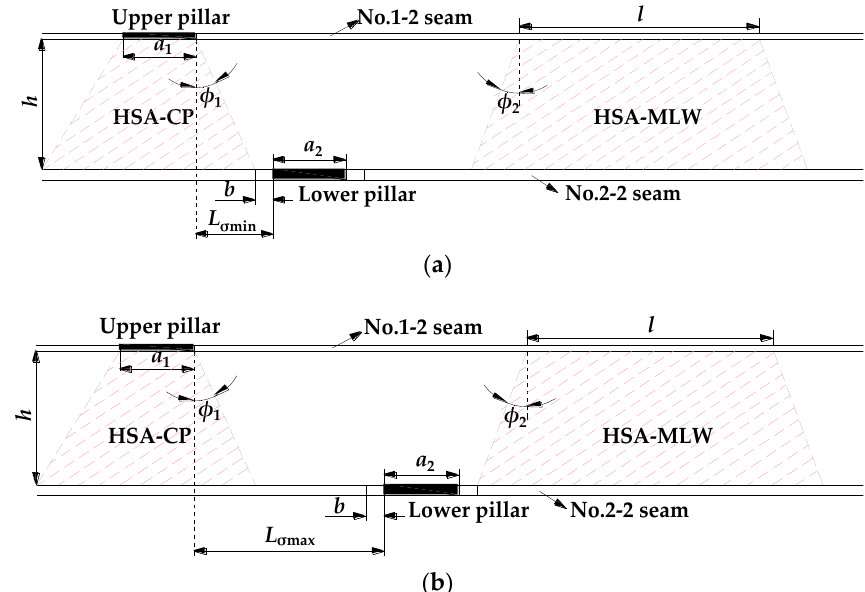
Figure 17. Model of CPMD based on physical simulation: ( a ) model of minimum CPMD; ( b ) model of maximum CPMD.